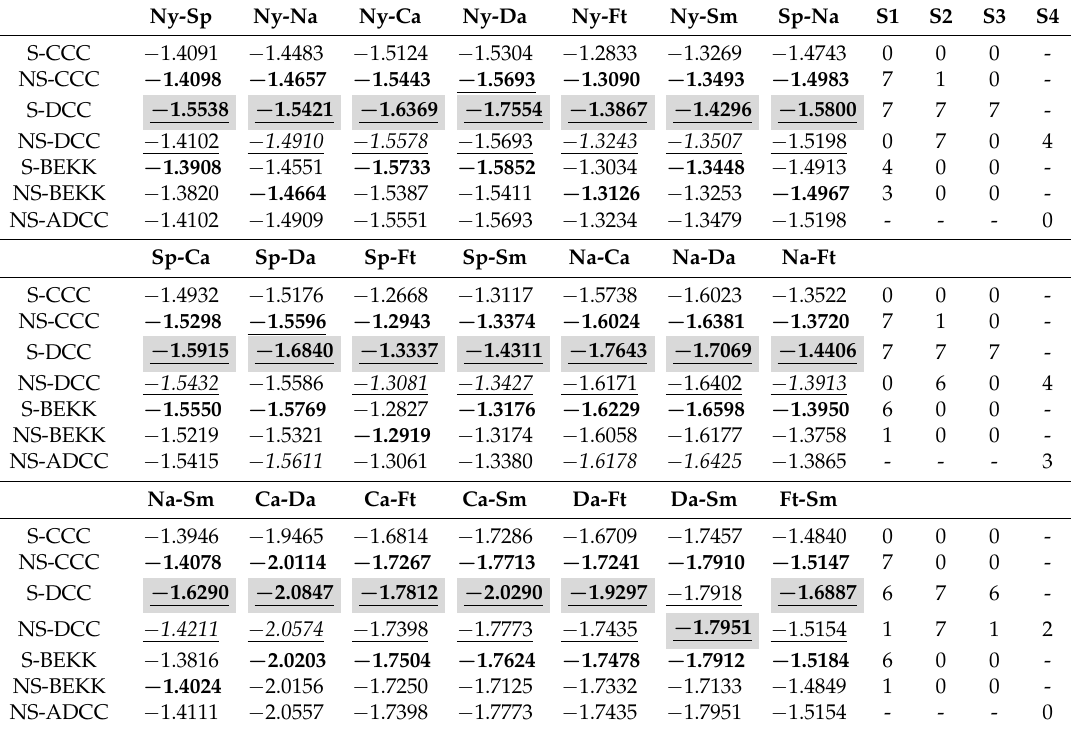
Table 4. The out-of-sample VaR forecasts performance based on the mean